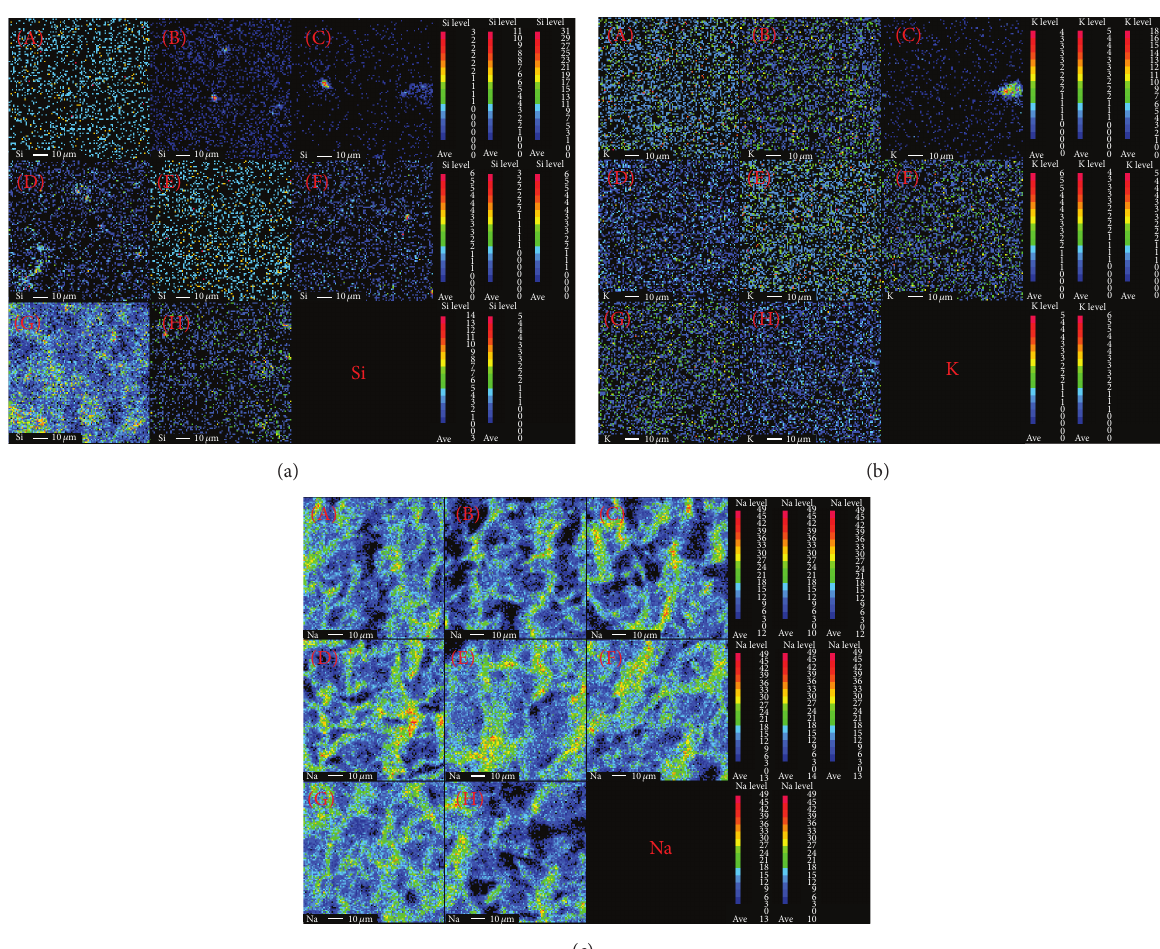
Figure 6: Wavelength dispersive X-ray analysis of Si, K, and Na in leaves of A. multiflora treated with silicon and NaCl. (A) MS medium, (B) MS + 1.8mM Si, (C) MS + 3.6 mM Si, (D) MS + 7.2mM Si, (E) MS + 50 mM NaCl, (F) MS + 50 mM NaCl + 1.8 mM Si, (G) MS + 50mM NaCl + 3.6 mM Si, and (H) MS + 50 mM NaCl + 7.2mM